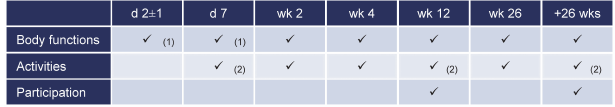
TABLE 3 | Measurement time points of the core set for clinical motor rehabilitation after